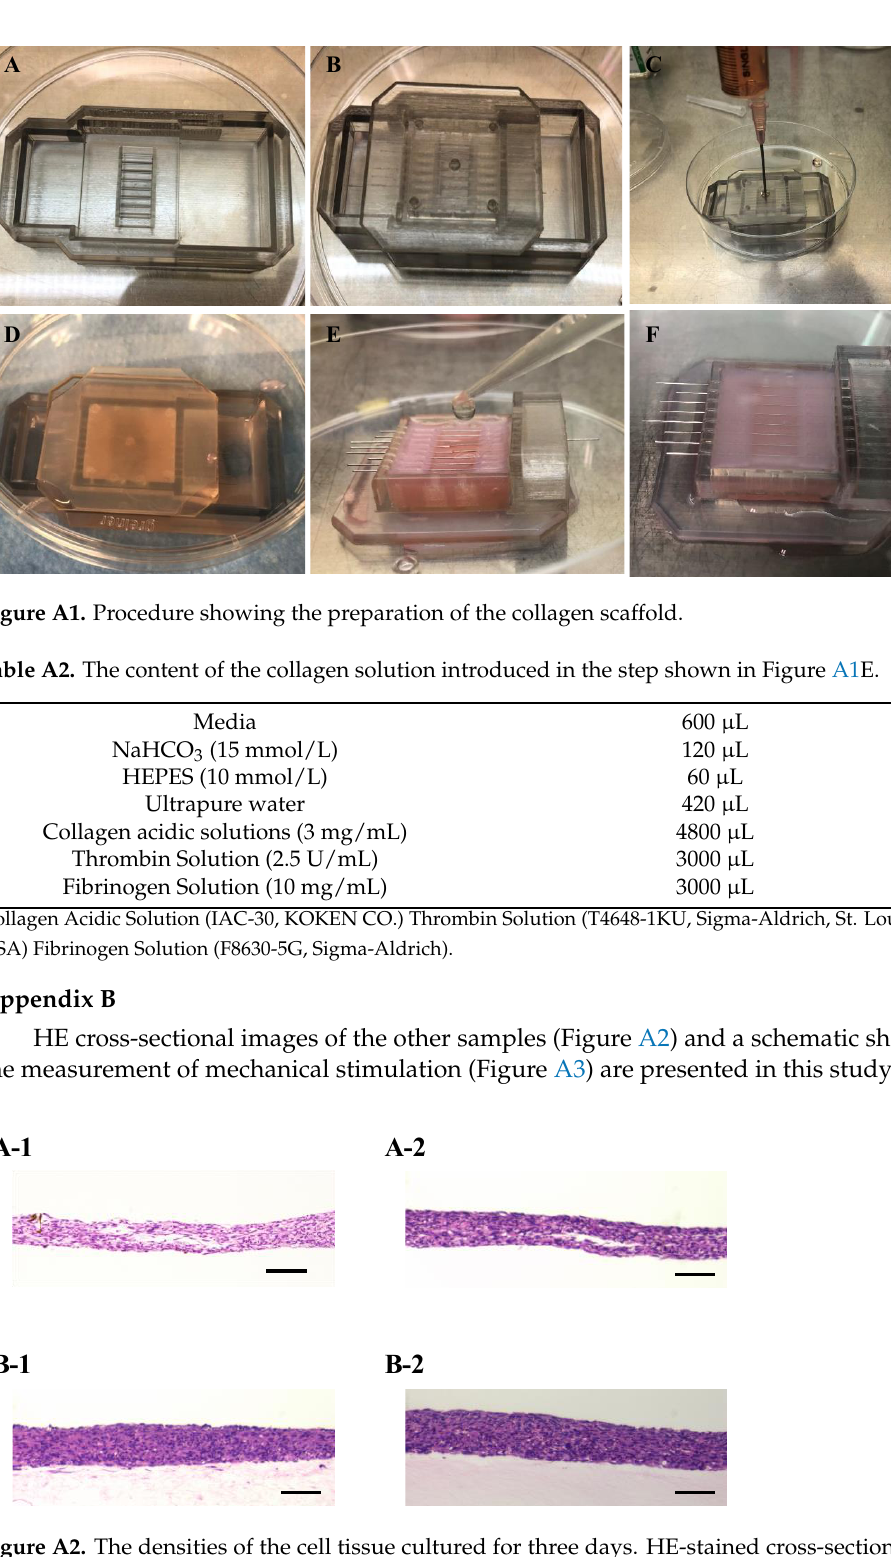
Figure A3. The schematic image shows the evaluation methods for shear stress from the media flow (left upper side) and the tensile deformation due to the leaky flow toward the bottom of the tissue. References 1.